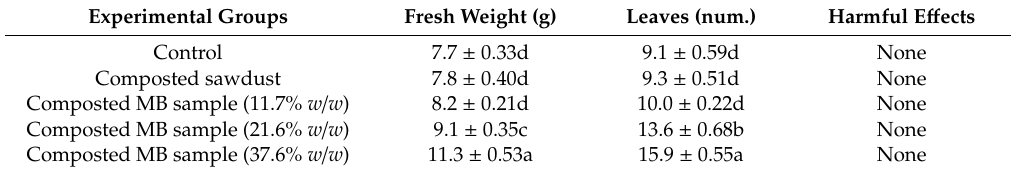
Figure 7. Growth change of Perilla sp. by application of MB fertilizer. ( a ) control and ( b ) composted MB sample (37.6% w / w ). I-IV shows the di ff erence in biomass of Perilla sp. at each point by application of MB fertilizer. Table 5. Biomass productivity results of Perilla sp. through the application of di ff erent MB fertilizers. a–d means a statistically significant di ff erence for each analysis